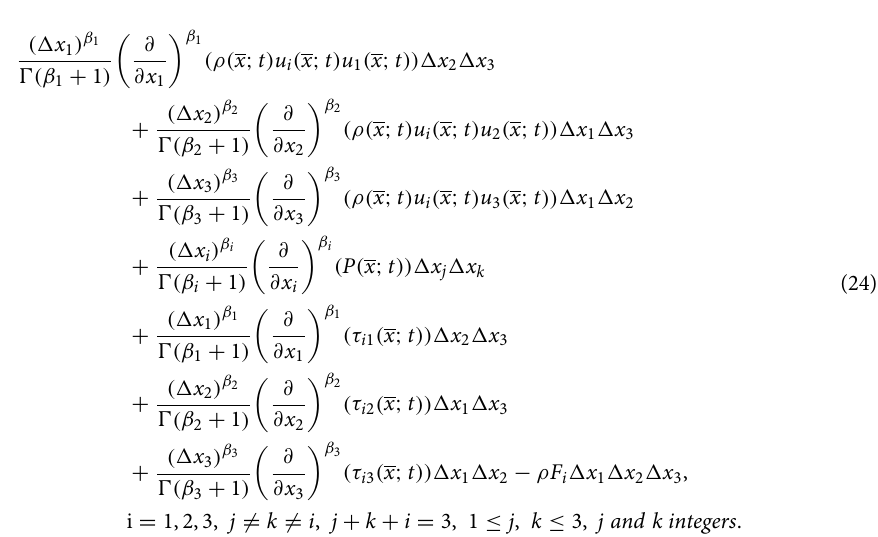
Figure 3. Surface forces in the momentum